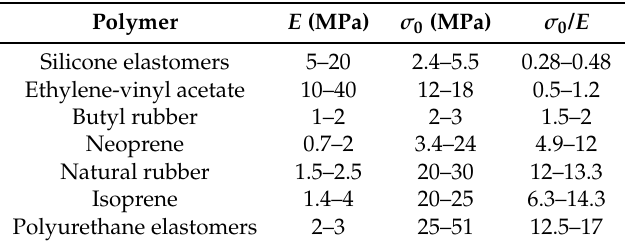
Table 1. Characteristic values of Young’s modulus E , yield stress σ 0 , and their ratio for different polymers (from Ref. [47]).